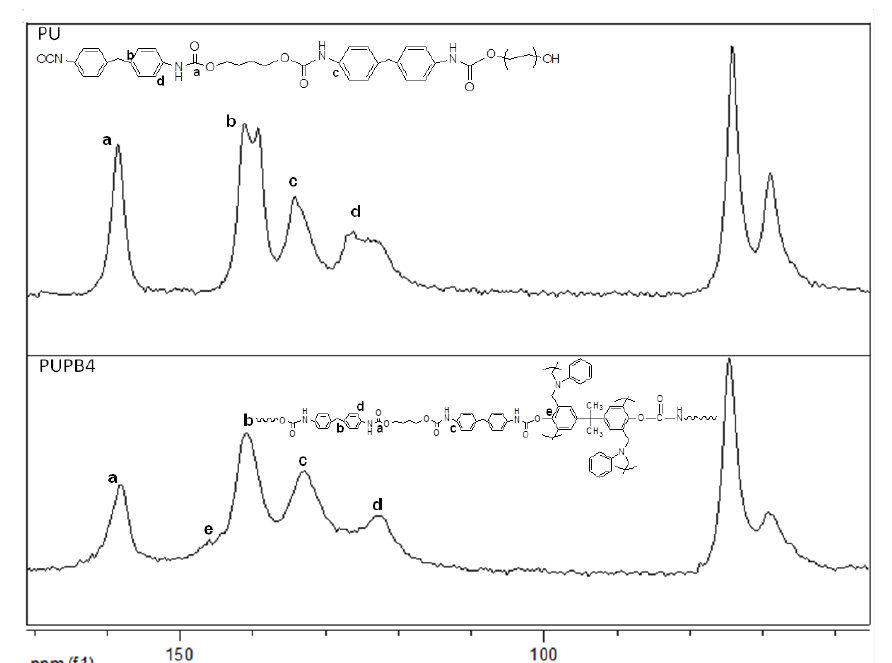
Figure 4. 13 C NMR spectra of gPU and